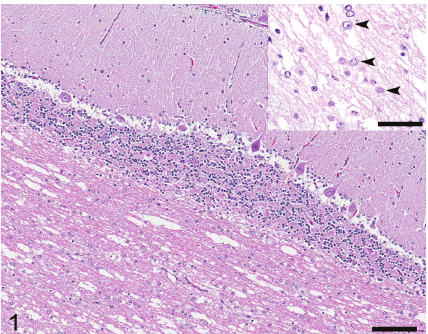
Figure 1: Brain from index case: note marked vacuolation of cere- bellar white matter (status spongiosus) with sparing of gray matter. Vacuoles (edema) are empty with the long axis parallel to axons. Bar = 100 𝜇 m. Inset: cerebellum at 100x magnification: many astro- cytes in the white matter are reactive with an increased amount of eosinophilic cytoplasm (arrowheads). Bar = 35 𝜇 m. Hematoxylin and Eosin